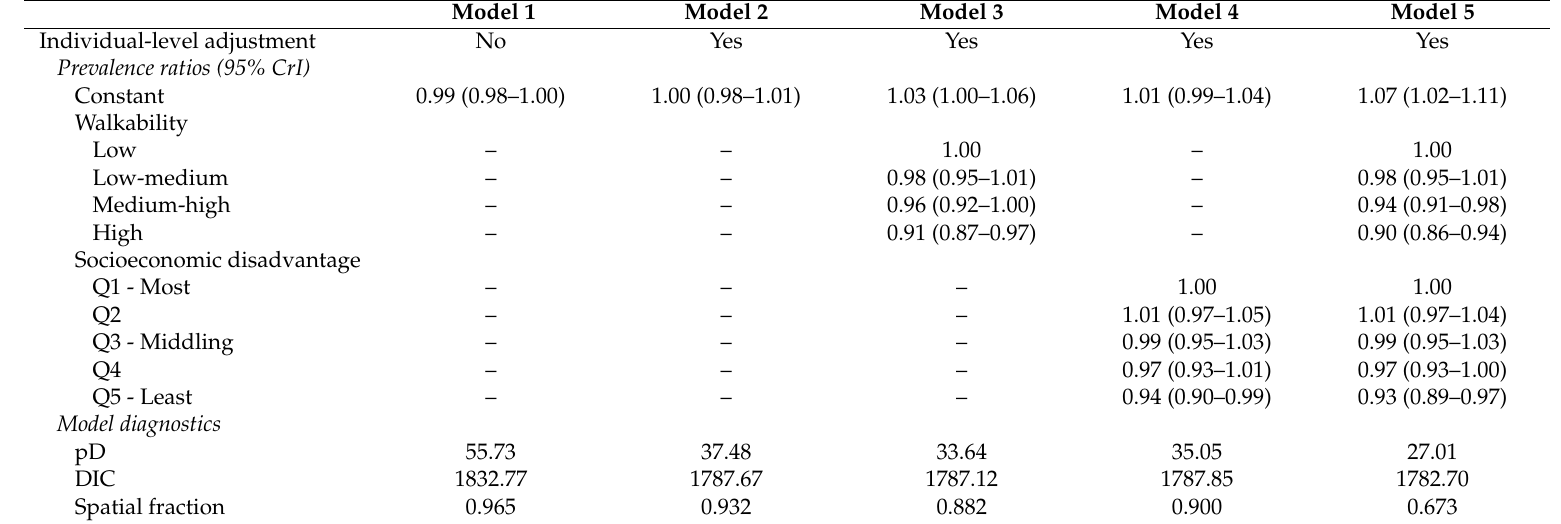
Table 3. Spatial regression summaries for postal area analyses of associations between overweight, walkability and relative socioeconomic